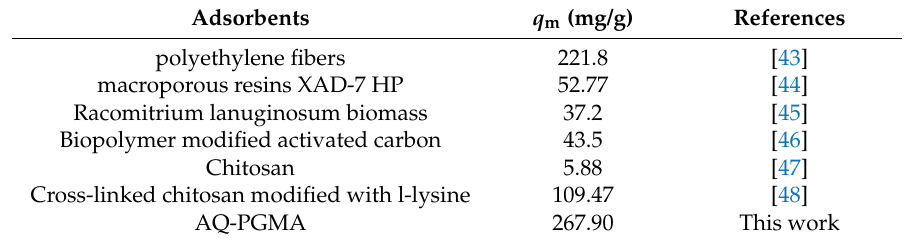
Table 5. Sorption capacity of AQ-PGMA against other sorbents reported in the literature.